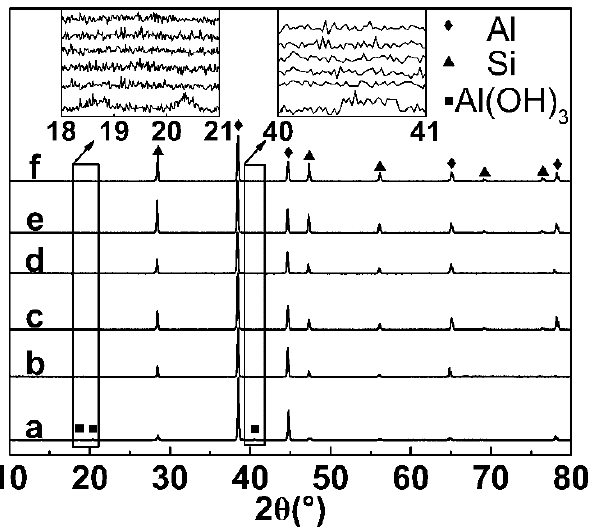
Figure 1. XRD patterns of the precursors: ( a ) A17W6, ( b ) A17H6, ( c ) A27W6, ( d ) A27H6, ( e ) A37W6, and ( f ) A37H6.